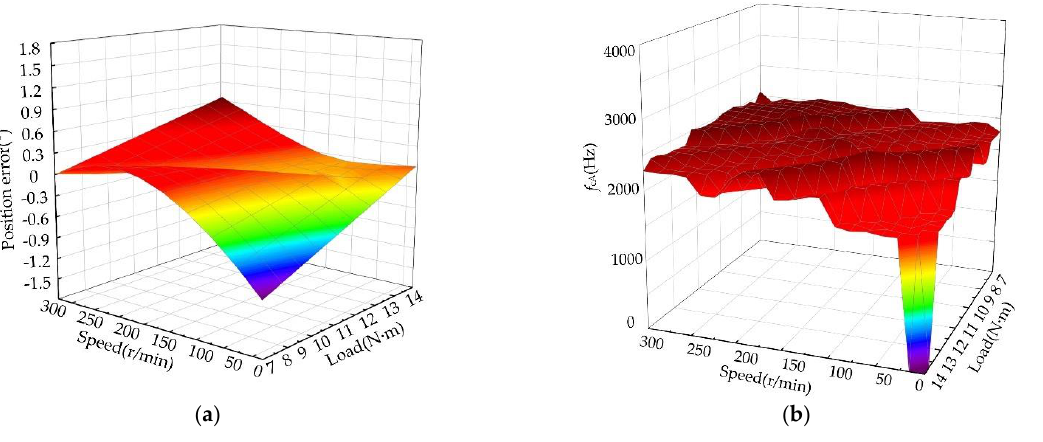
Figure 14. Results within 300 r/min: ( a ) Rotor position error at different speeds and loads; ( b ) Waveform of center frequency f cA variation.